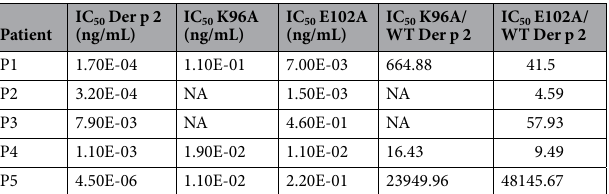
Table 3. Inhibition of IgE binding to immobilized WT Der p 2, by addition of mutant K96A or E102A. IC 50 refers to the concentration of allergen that inhibits 50% of the IgE from binding to immobilized WT Der p 2. The fold difference between the concentrations of mutant and wild type protein to cause 50% inhibition is